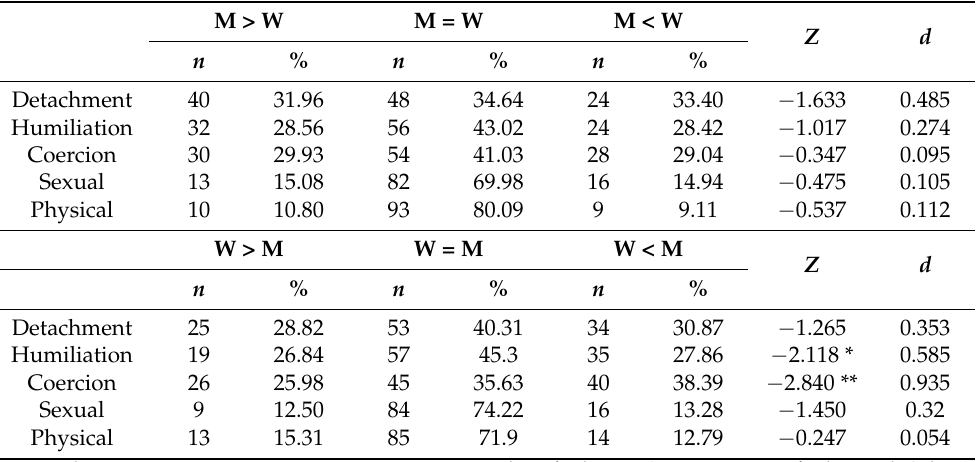
Table 5. Agreement on the frequency of the factors of violence (DVQ-R) perpetrated in the violent couples. Proportion of men and women who report greater violence than their partner (>), the same (=) and less violence (<).